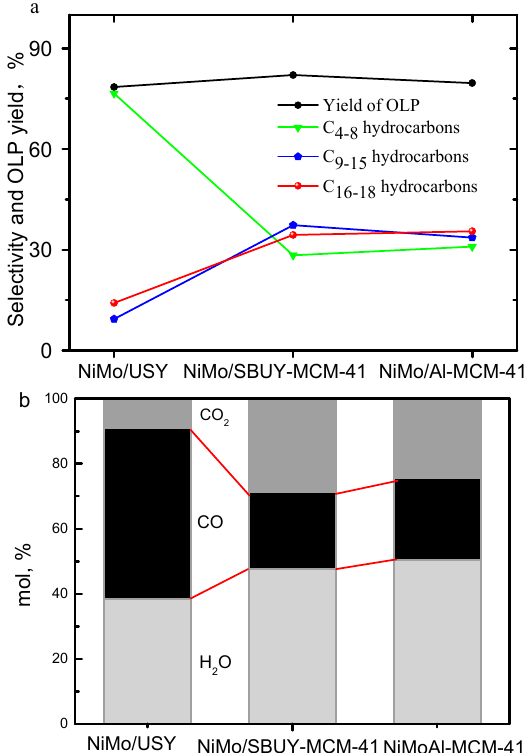
Figure 3. ( a ) Hydrocarbon distribution and ( b ) distribution of H 2 O, CO, and CO 2 products over different catalysts. Reaction conditions: 380 °C, 3 MPa, 500 mL/mL.